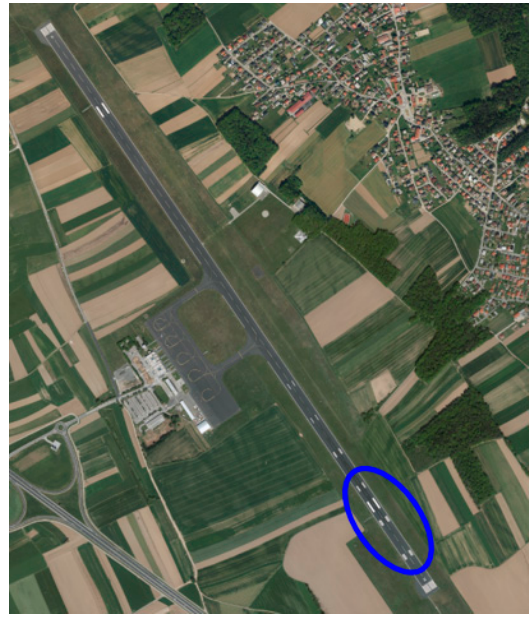
Figure 1. The whole runway and measurement area.